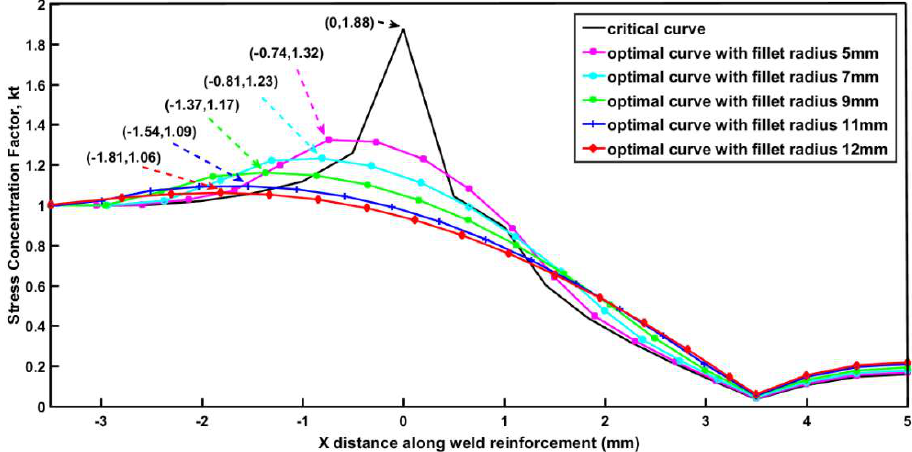
Figure 8. The influence of the transition arc radius r 1 on the distribution of stress concentration factor along the welded joint.